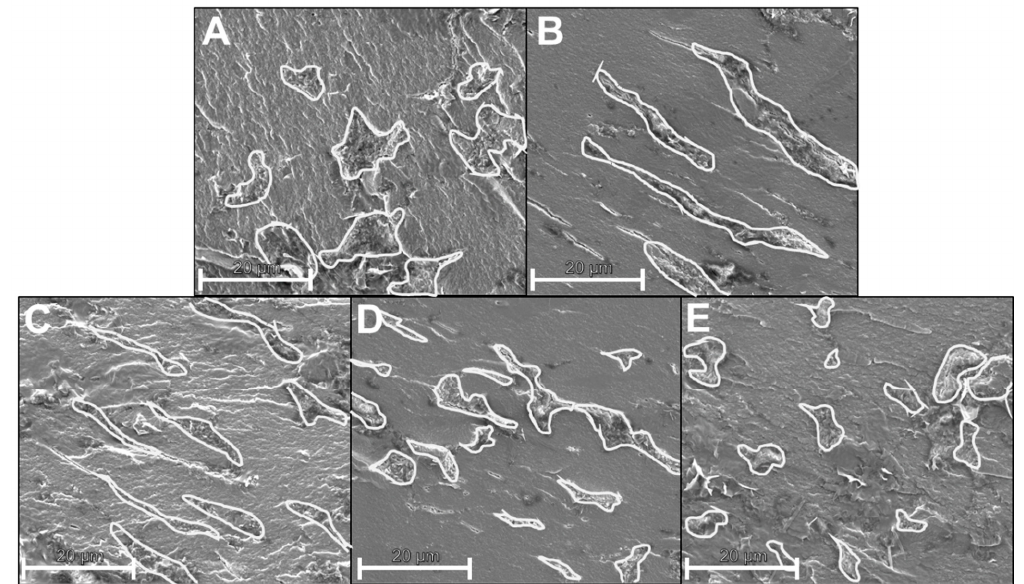
Figure 10. SEM-images of pellets from SPI + 30% WPC, which underwent a defined, extrusion-like thermal treatment at 125 °C, were cooled to 90 °C and then deformed for a given shear rate in the CCR: ( A) 0 s − 1 , ( B ) 0.25 s − 1 , ( C ) 1 s − 1 , ( D ) 2.5 s − 1 , ( E ) 10 s − 1 .